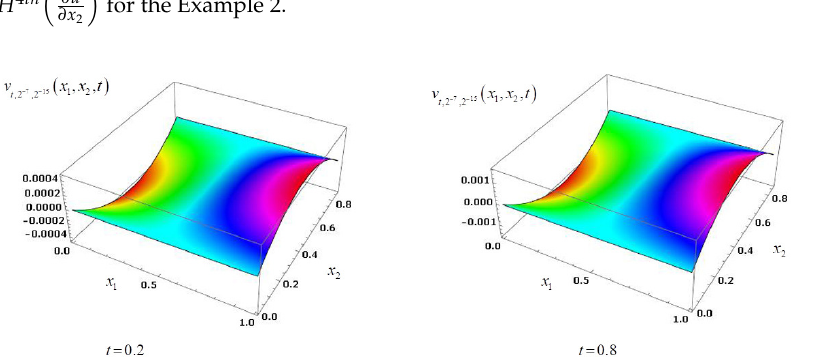
Figure 8. The approximate solution v t ,2 − 7 ,2 − 15 at time levels t = 0.2 and t = 0.8 obtained by the